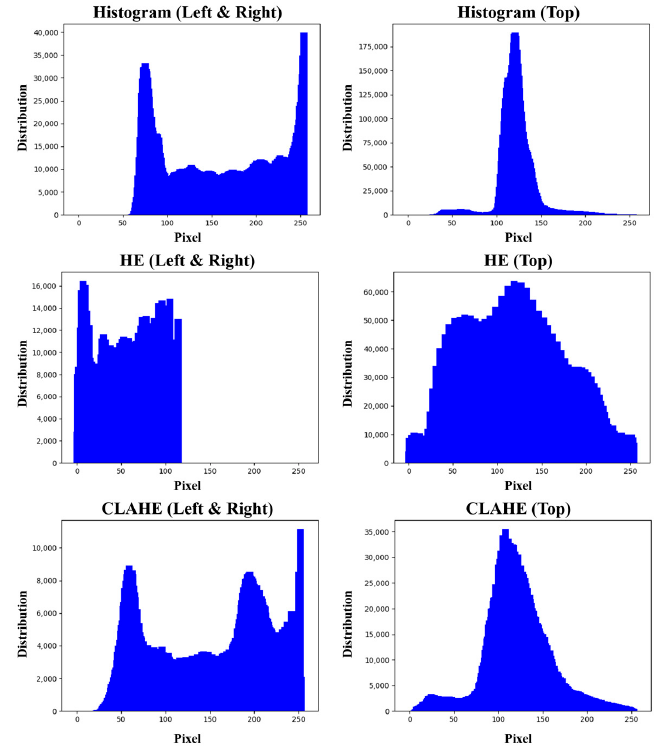
Figure 13. Histograms (HE and CLAHE).